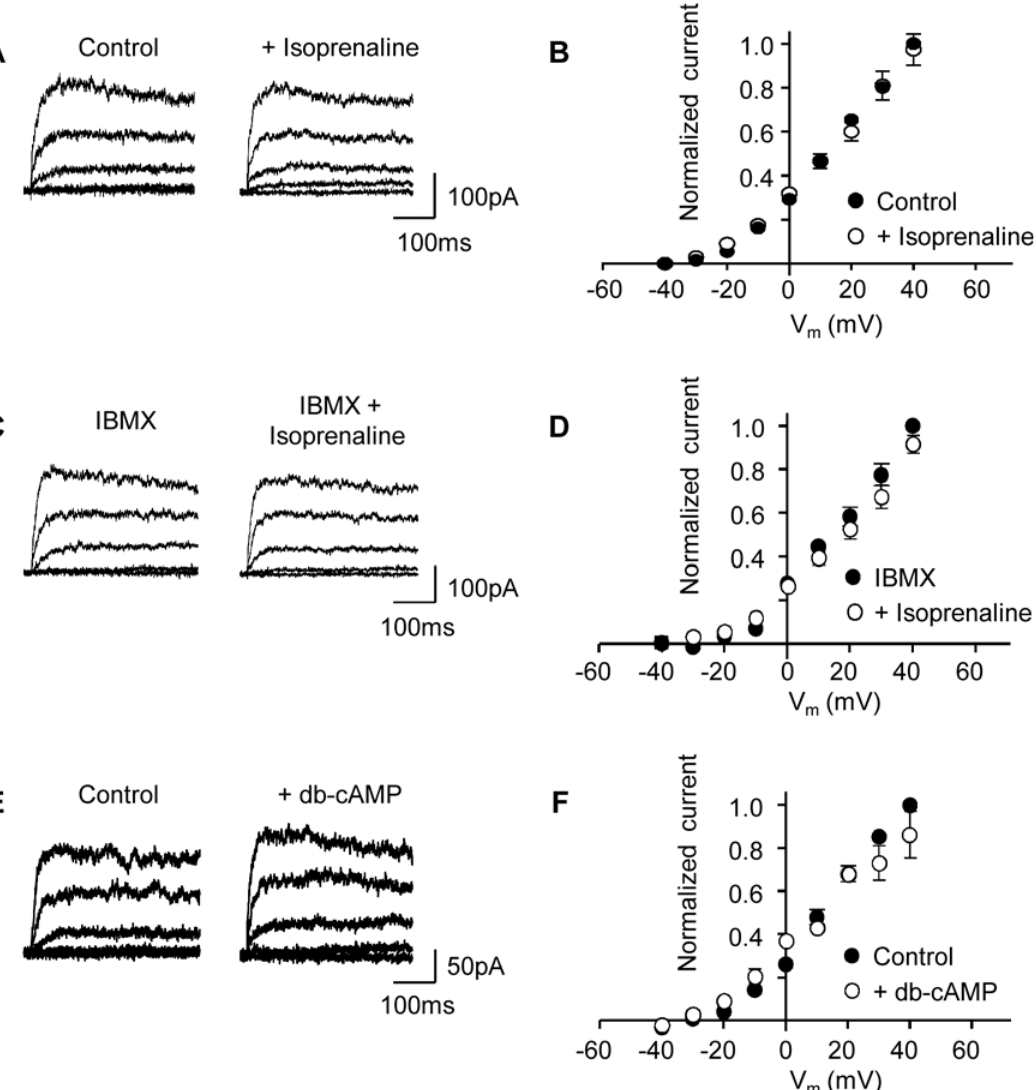
Fig 3. Activation of PKA does not increase K v current. ( A ) Representative K v current traces obtained before and after application of isoprenaline (1 μ M) as indicated. ( B ) Mean ( ± s.e.m.) I-V plots (normalized to control current at +40 mV) before and after application of isoprenaline (1 μ M; n = 8). ( C ) Representative K v current traces as in panel A, but in the presence of IBMX (300 μ M) before and after application of isoprenaline (1 μ M). ( D ) Mean I-V plots (normalized to the control current in IBMX at +40 mV) before and after application of isoprenaline in the presence of IBMX (n = 5). ( E ) Representative K v current traces before (control) and after application of dibutyryl-cAMP (db-cAMP; 100 μ M). ( F ) Mean ( ± s.e.m.) I-V plots (normalized to the control current at +40 mV) before and after application db-cAMP (100 μ M; n =